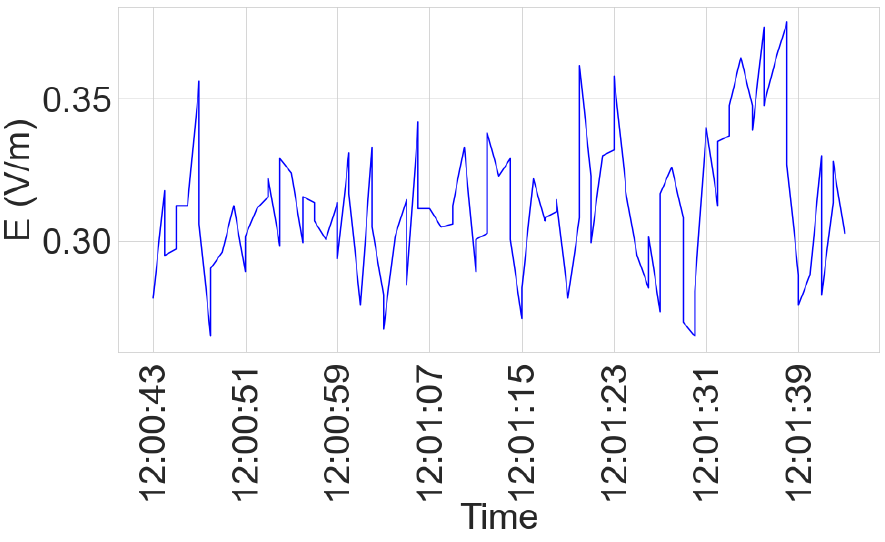
Figure 6. Broadband measurement variability over one minute.